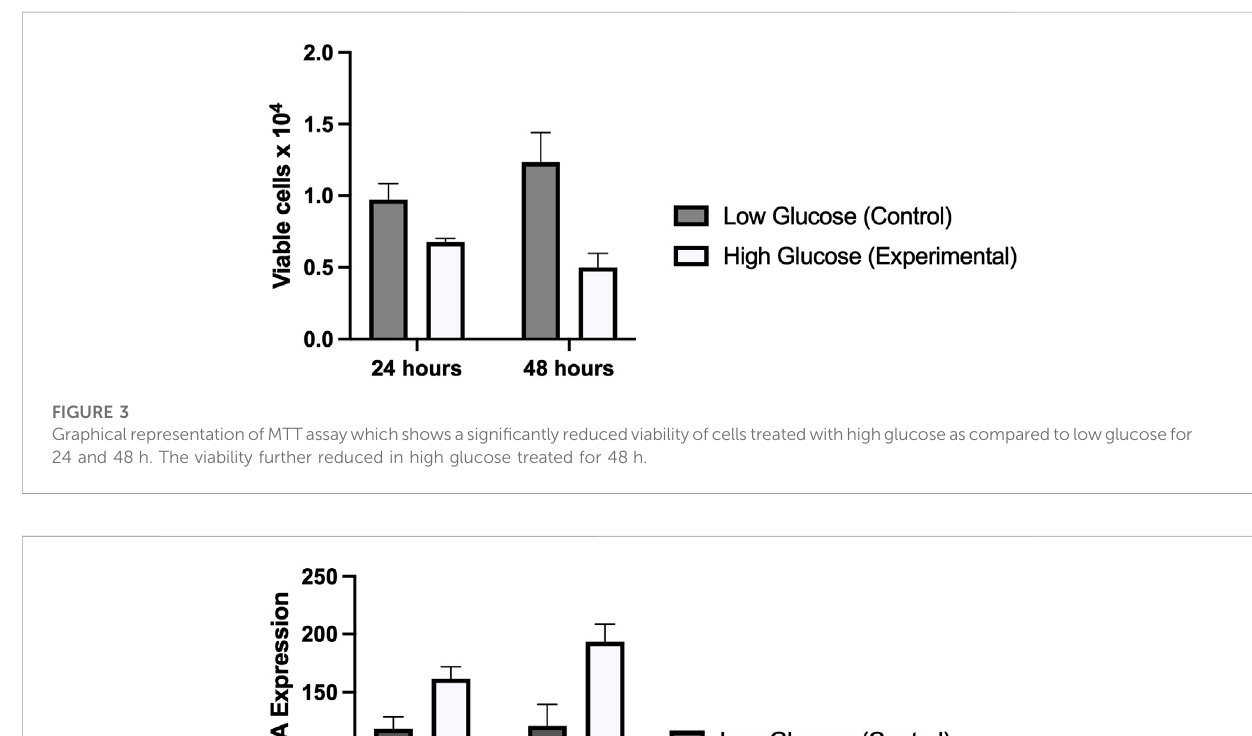
RNA was isolated from high and low glucose treated cell lysates using commercially available Gene JET RNA Puri fi cation kit